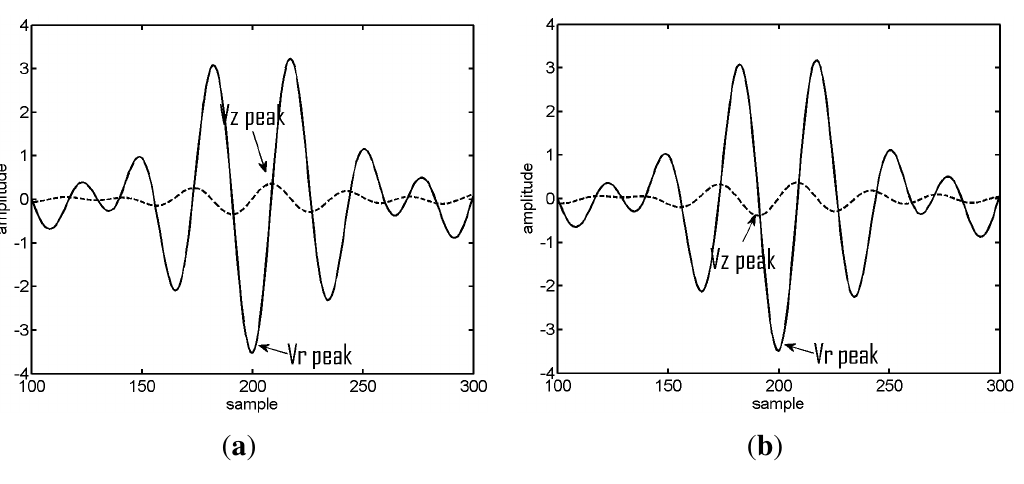
Figure 4. Zoom of the amplitude-delay curve in the neighborhood of the first echo for two signal realizations (5 dB SNR) at a source distance of 300 m showing the expected behavior ( a ) and a sign error ( b ). The horizontal particle velocity (Vr) is represented by the solid line and the vertical particle velocity (Vz) by the dashed line. The arrows indicate the